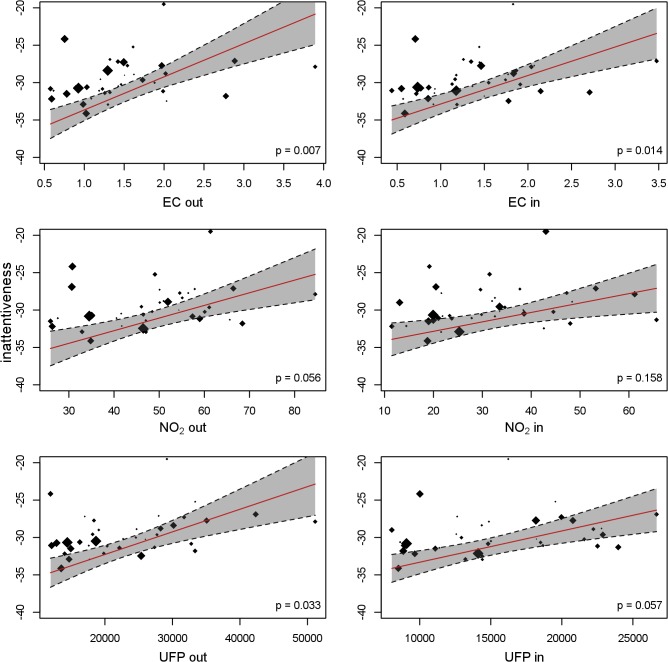
Inattentiveness development and long-term exposure to traffic-related air pollutants.Each dot depicts a school, with size proportional to the number of children. The cognitive development per school was estimated in a model with school and individual as random effects. The slope of the red line depicts the change in cognitive development as a function of the air pollutants, adjusted for age, sex, maternal education, residential neighborhood socioeconomic status, and air pollution exposure at home; school and individual as nested random effects in 2,715 children and 10,112 tests from 39 schools. Gray shading indicates 95% CI. out, outdoors (courtyard); in, indoors (classroom).